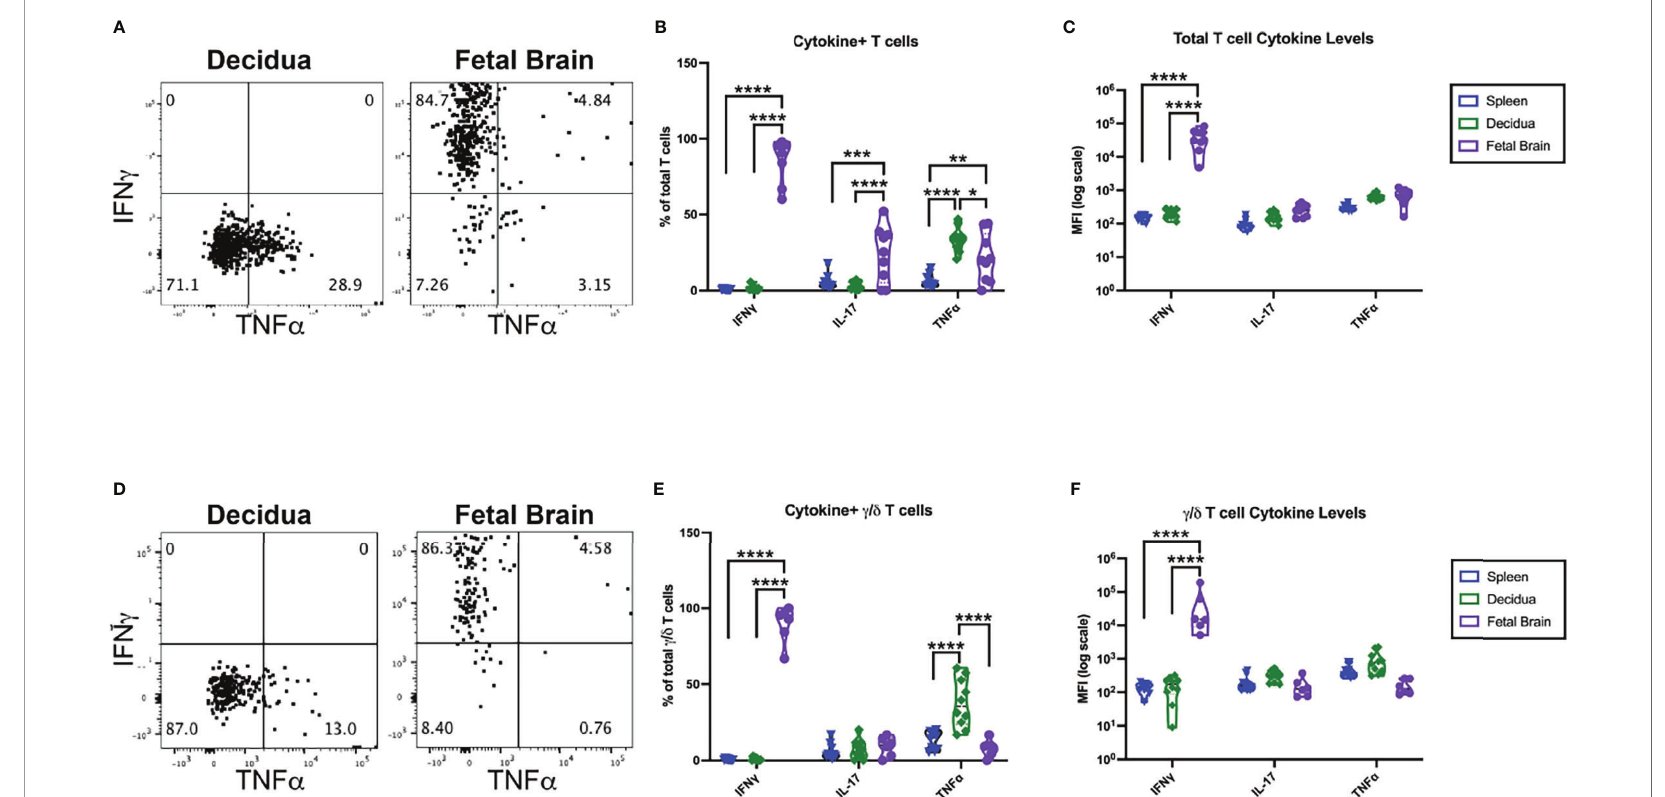
FIGURE 7 | g / d T cells from the fetal brain, but not from the maternal spleen or decidua, are producing IFN g ;. CD3+ cells were isolated from tissues collected at 72 hours post-exposure to IUI. CD3+ cells were stimulated in vitro and stained for intracellular cytokines as well as T cell receptor subtype. (A) Representative fl ow plots from the decidua and fetal brain are gated on non-debris, singlet, live, CD45+, CD3+ cells. (D) Representative fl ow plots of cytokines in g / d T cells followed the same gating scheme, with the additional gates of TCR b - and TCR gd +. Cytokine expression was analyzed as (B) the % of T cells or (E) % of g / d T cells that were positive for each cytokine and as the MFI of either (C) total T cells or (F) g / d T cells. Cytokine data was analyzed by two-way ANOVA with post-hoc Tukey ’ s multiple comparison test comparing the expression of a single cytokine between tissues. *p<0.05, **p<0.01, ***p<0.001,